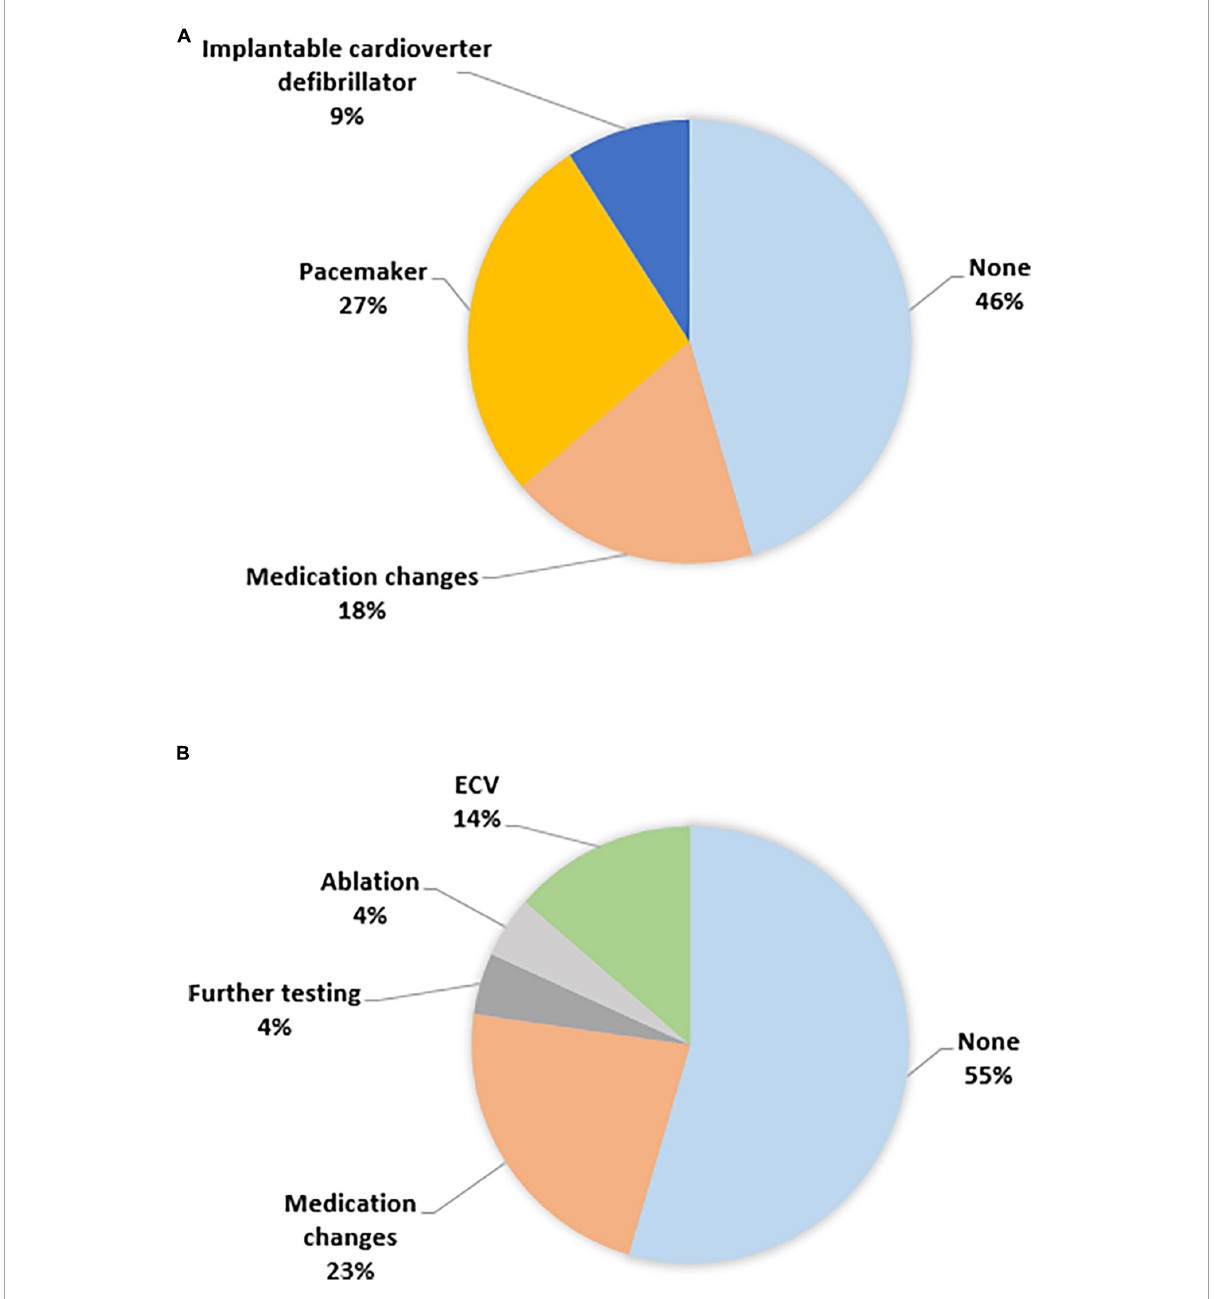
FIGURE2 Care changes (A) ILR and (B) smartphone